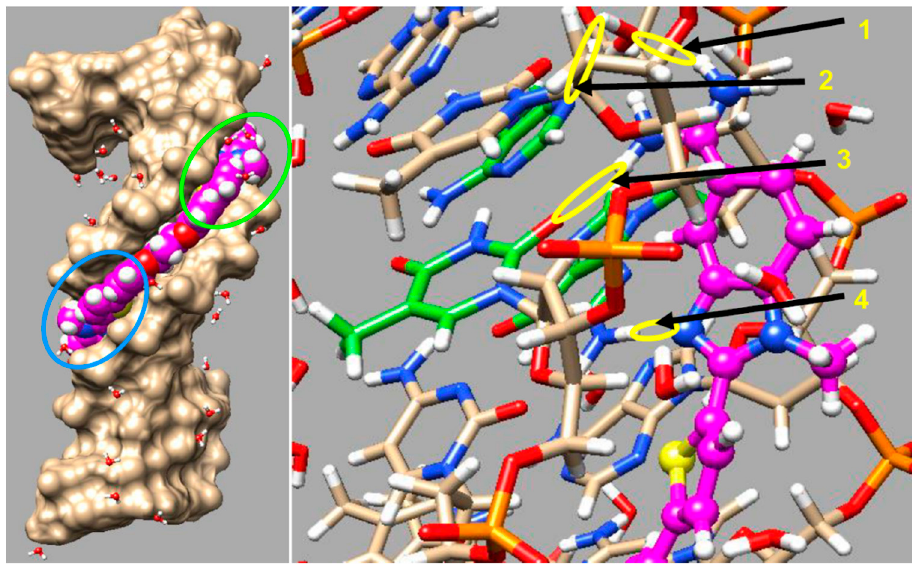
Figure 11. Molecular Dynamics (MD) model of DB2528 bound to a two G·C bps containing sequence AAAGAAACTTT site. A space filling model with DNA tan color is shown on the left where the compound DB2528 (magenta) covers a full helical turn of 10 bps in the minor groove. On the right side, the DNA bases are represented in tan-white-red-blue-orange (C − H − O − N − P) color scheme and DB2528 is magenta-white-blue-yellow (C − H − N − S) color scheme. The detailed important interactions, H-bonds and other interactions described in the text, between the symmetrical bis amidine-phenyl- N -methyl-BI-thiophene of DB2258 with DNA bases are shown with yellow color circle and arrows; arrow 1: Am-N-H---O-H 2 , arrow 2: H 2 -O---N3-dA, arrow 3: Am-NH---O=dT, arrow 4: BI-N---H-dG.